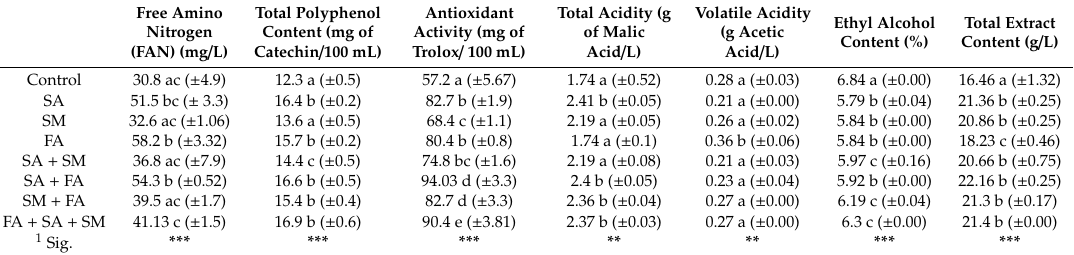
Table 6. Physicochemical parameters for ciders fermented by distiller’s yeast (G), with the following additions: SA—ammonium sulfate, SM—magnesium sulfate, FA—ammonium